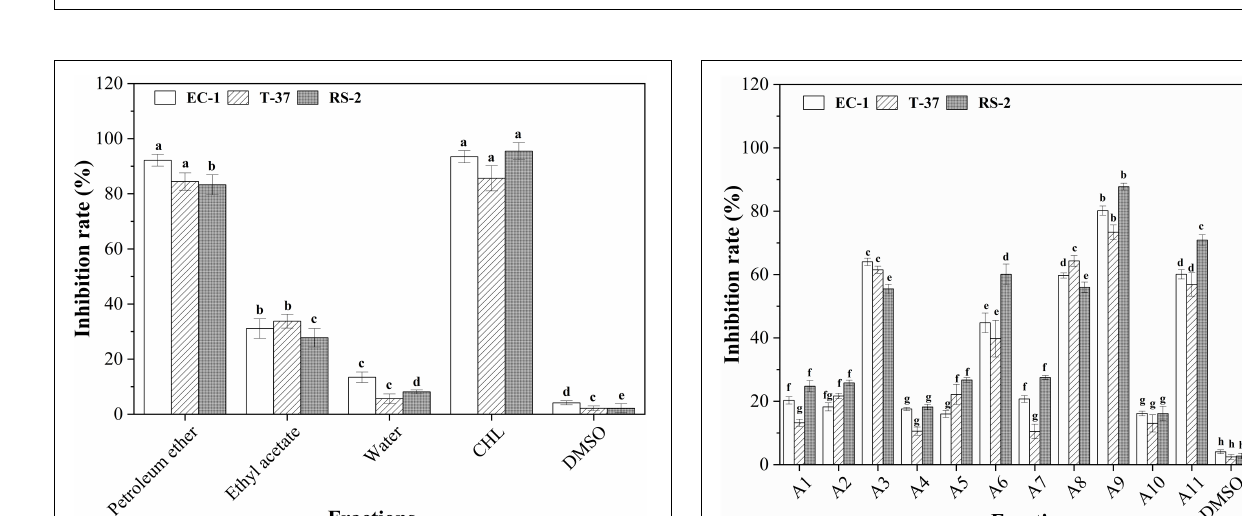
FIGURE 1 | The antibacterial activity guided fractionation of petroleum ether extract.